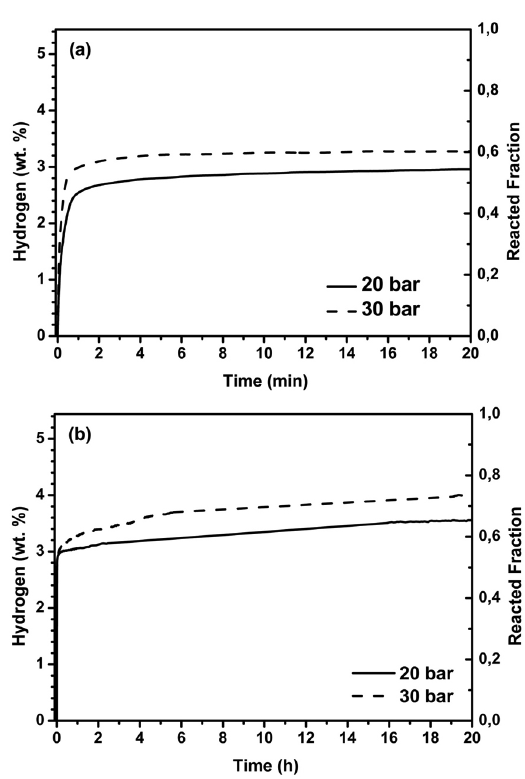
Figure 4. X-ray powder diffraction patterns of 2Mg-Fe sample after . The hydrogen absorption 2 hydrogen absorption tests at 350 °C under 20 and 30 bar of H (a) 20 minutes and (b) 20